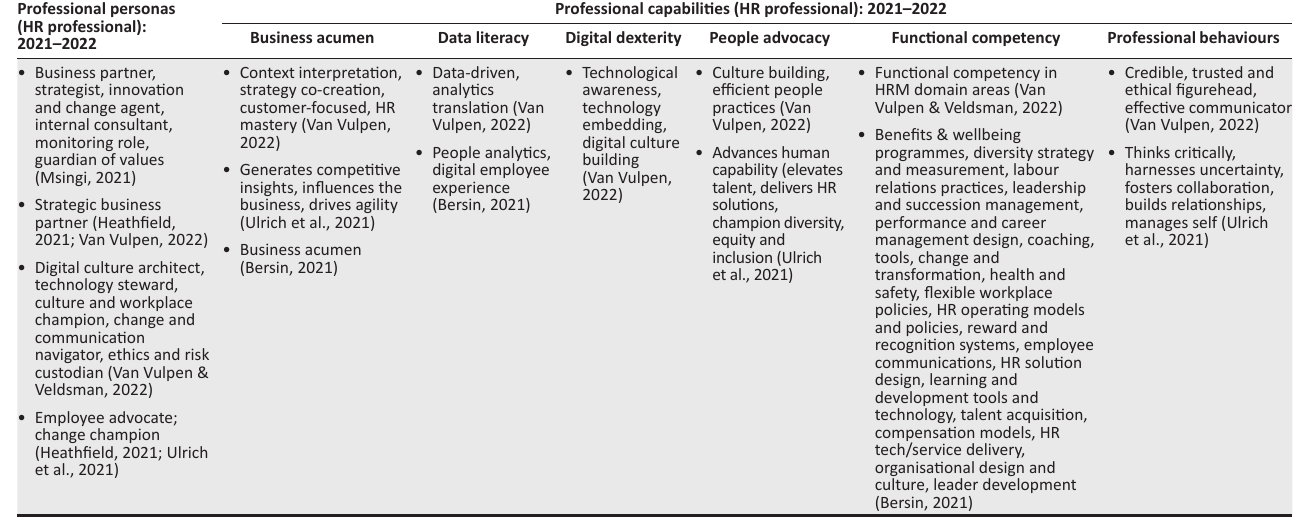
TABLE 1: Overview of professional personas and capabilities of the human resource professionals: 2021–2022. Professional personas (HR